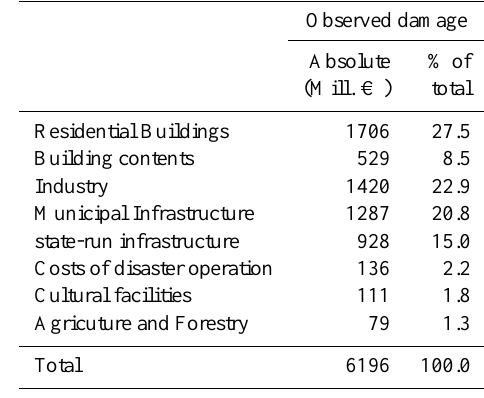
Table 8. Recorded flood damages in Saxony during the Elbe flood in